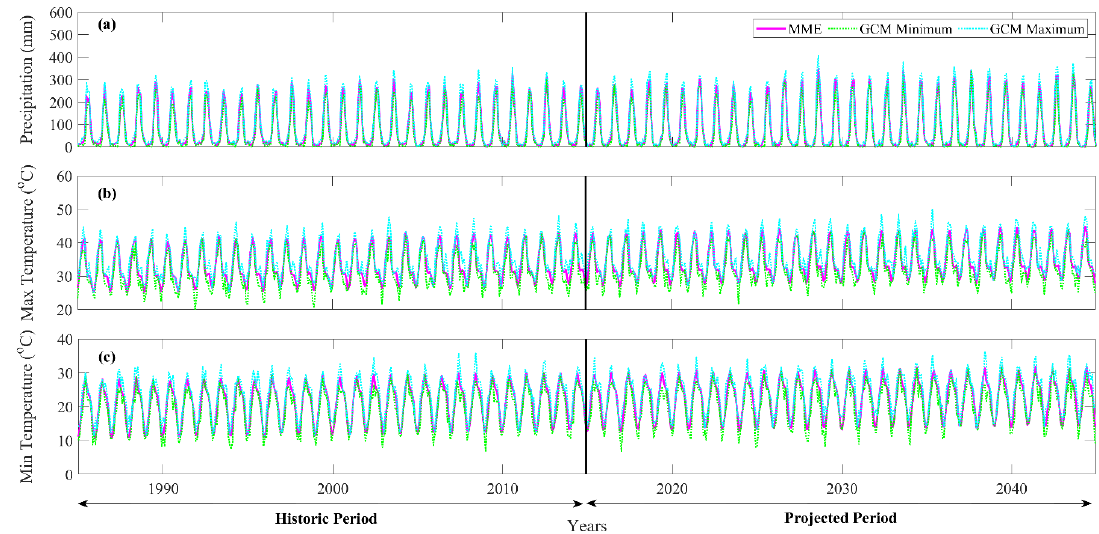
Figure 4. Time series of maximum and minimum values of GCM and the MME mean for Kansabati river basin (KSB). ( a ) Precipitation; ( b ) maximum temperature; ( c ) minimum temperature.